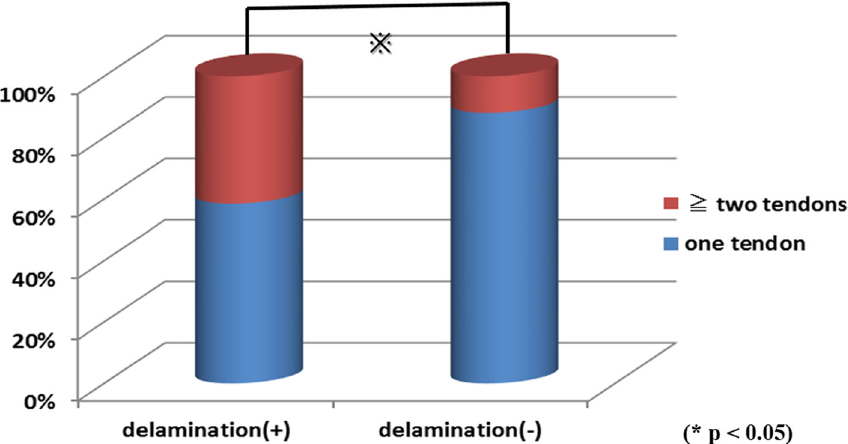
Figure 3. Rate of number of torn tendon.